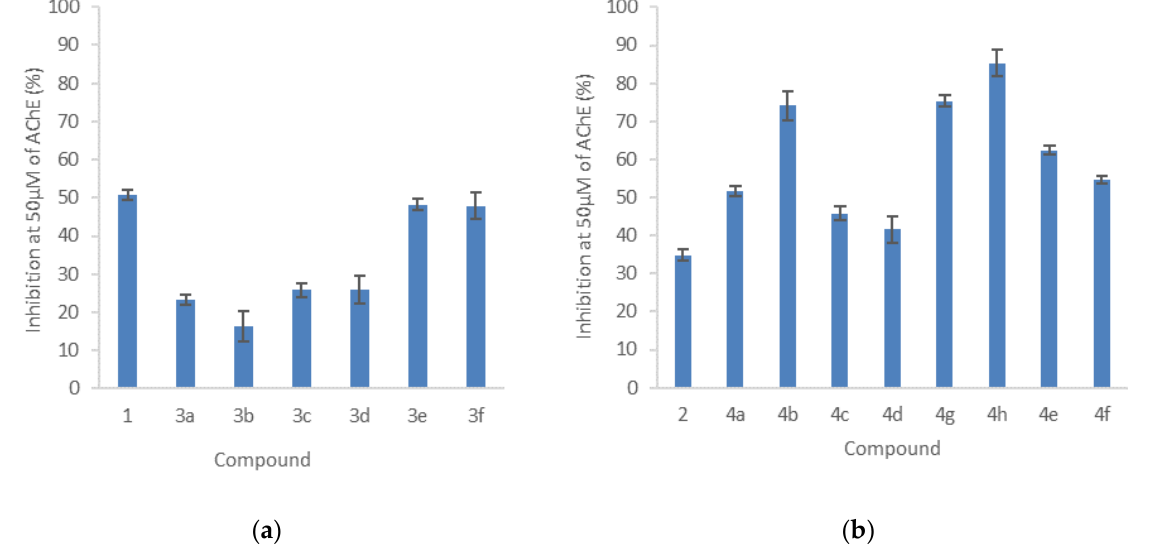
Figure 4. Inhibitory activities against AChE at a concentration of 50 µM – Inhibition 50µM values for ( a ) 1,4-NQ and their derivatives 3a – f ; ( b ) 1,2-NQ and their derivatives 4a – h . Values were calculated using Graph Pad Prism and expressed as the mean ± SD.